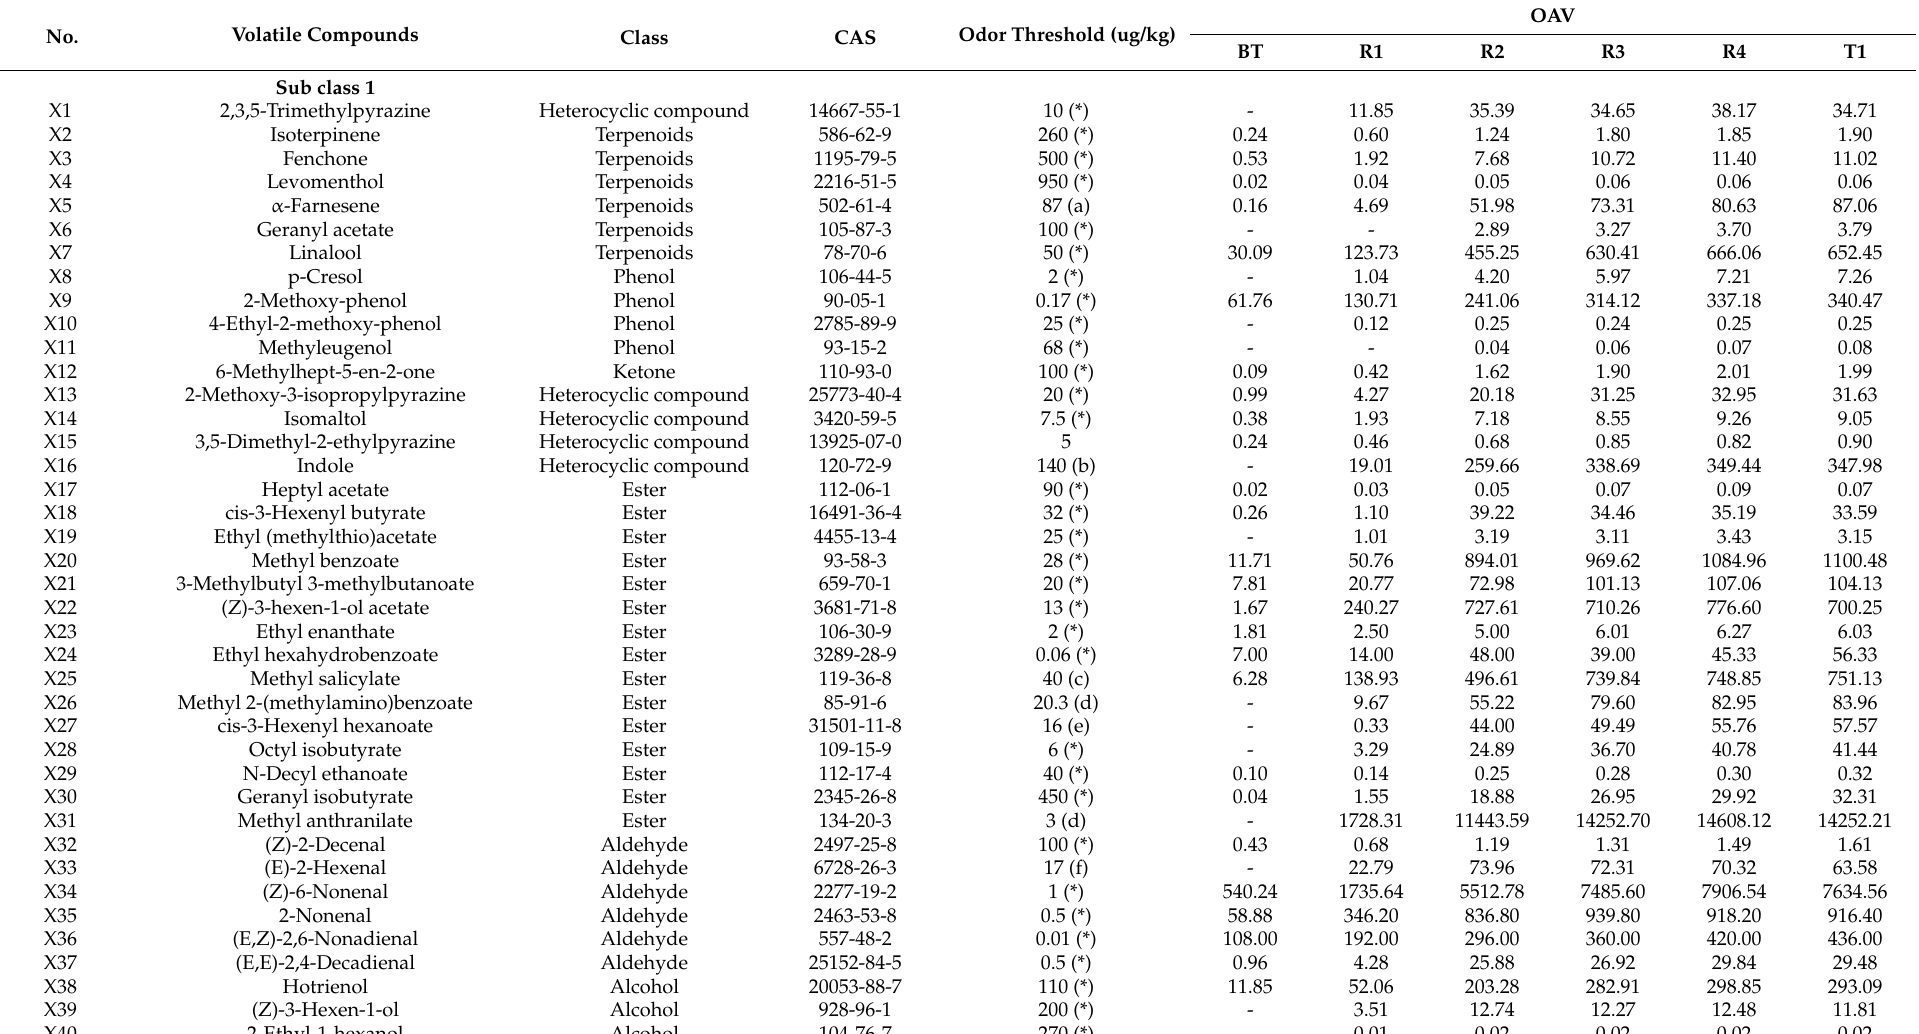
Table 1. The odor activity values (OAVs) of differential volatile organic